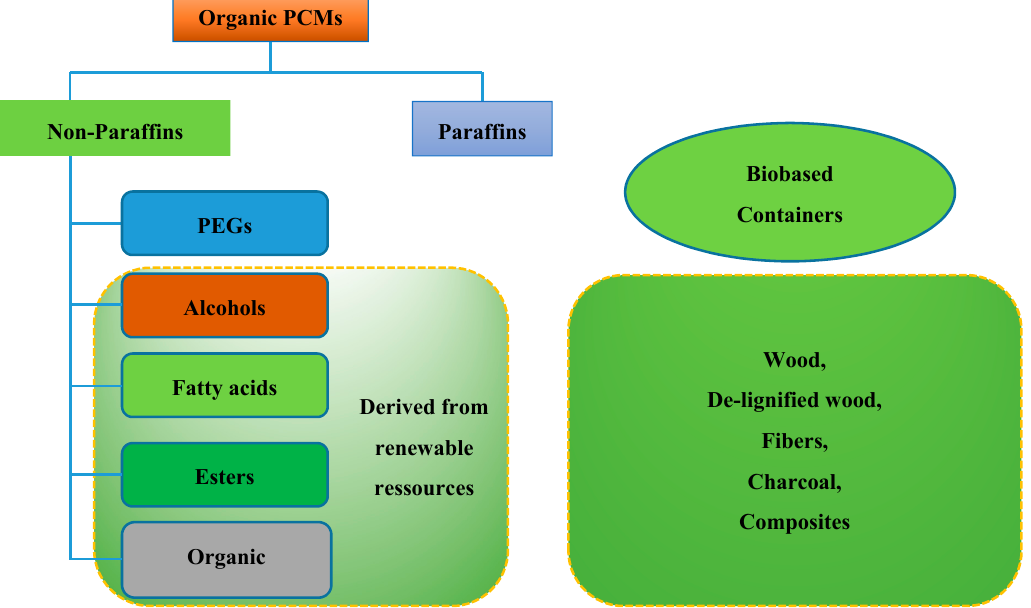
Figure 2. Diagram of organic PCMs’ classification and the possible bio-based containers.